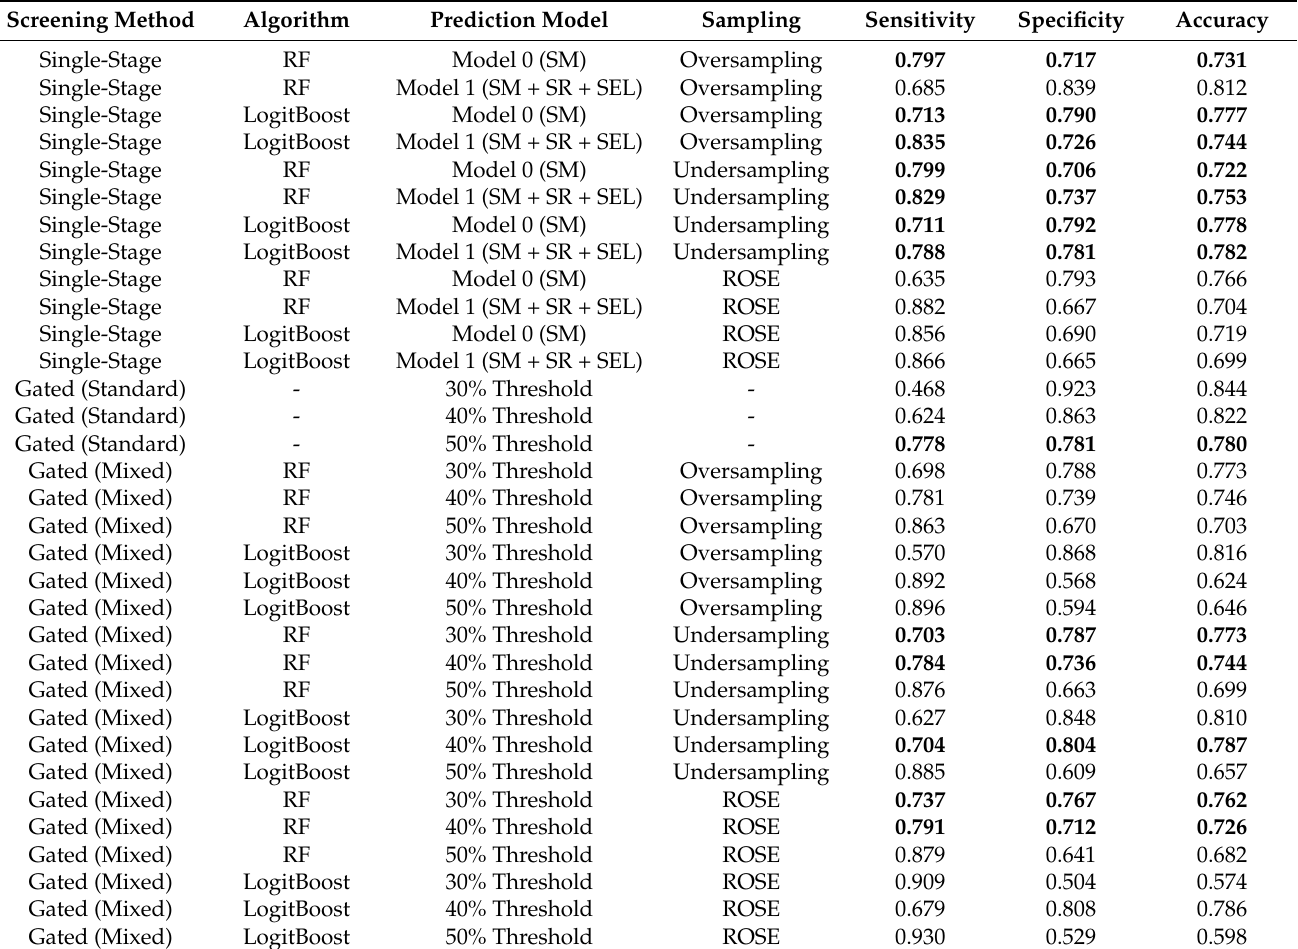
Table 1. Sensitivity, Specificity, and Accuracy Results for the 2016–2017 School